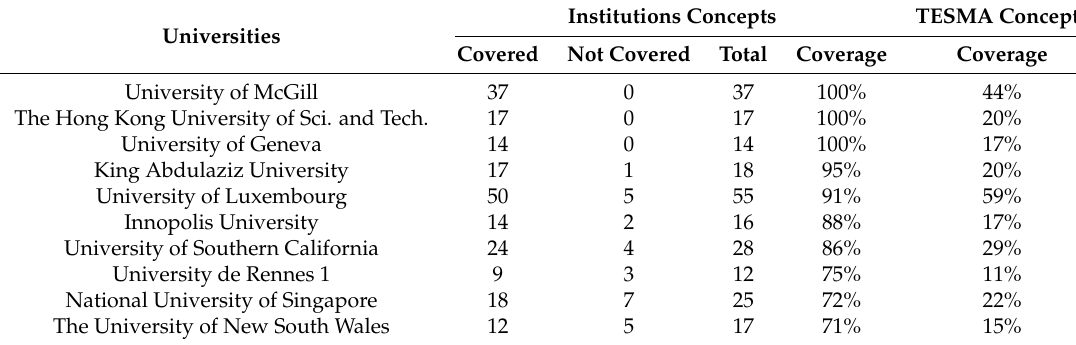
Table 2. Results of the survey on the 10 universities’ conceptual